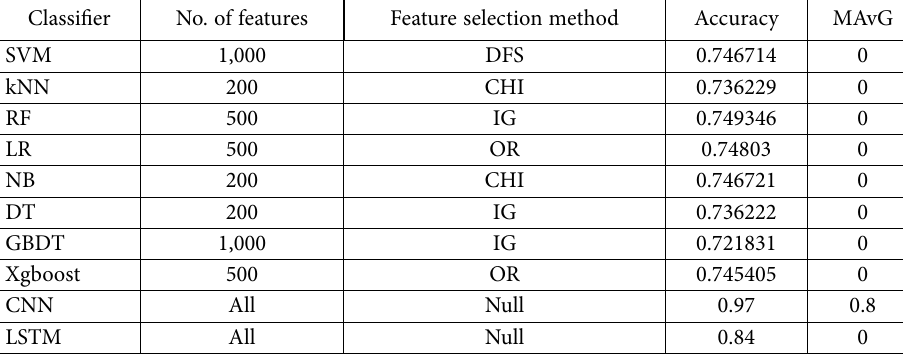
Table 7. Performance (partial) of different classifiers